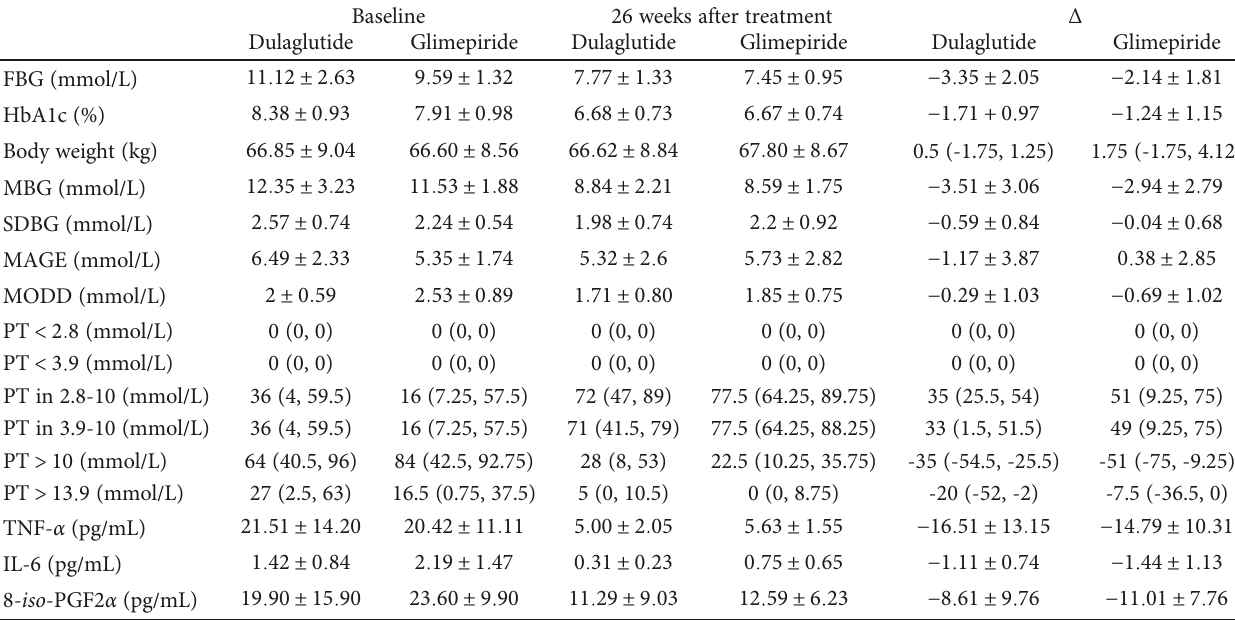
Table 3: Comparison of blood fl uctuation, oxidative stress, and in fl ammatory pro fi le between the dulaglutide and glimepiride groups. Baseline 26 weeks after treatment Δ Dulaglutide Glimepiride Dulaglutide Glimepiride